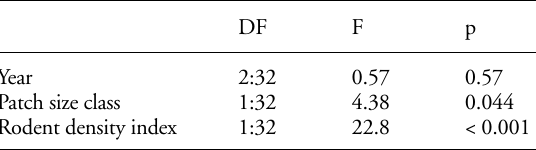
Table 2. Three-way analysis of covariance, testing for effects on seed predation. Interactions were not significant and are not included in the tests.